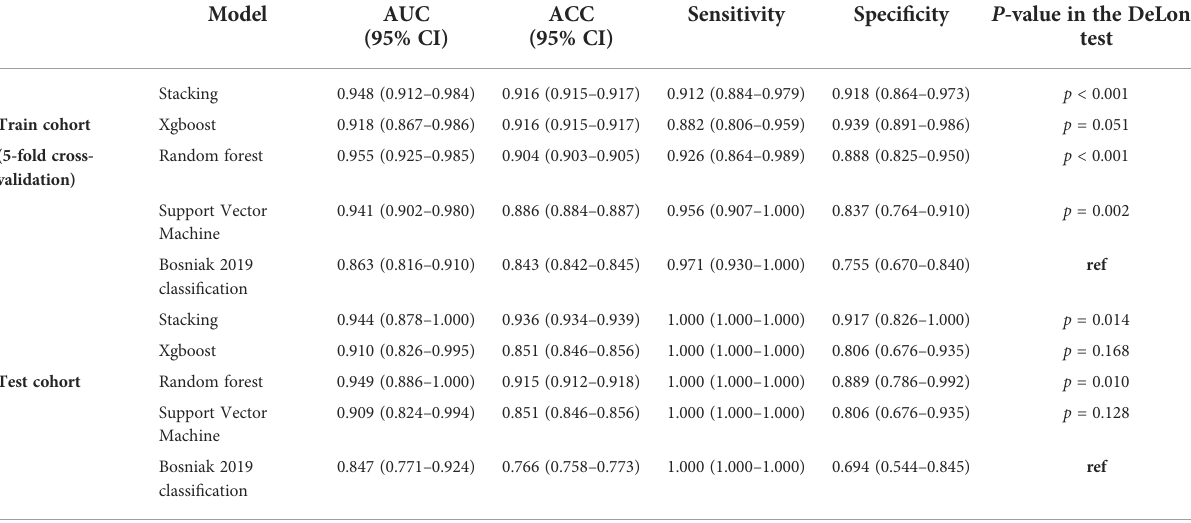
TABLE 2 The performance of predictive models and the Bosniak 2019 version classi fi cation in the testing cohort and training cohort.